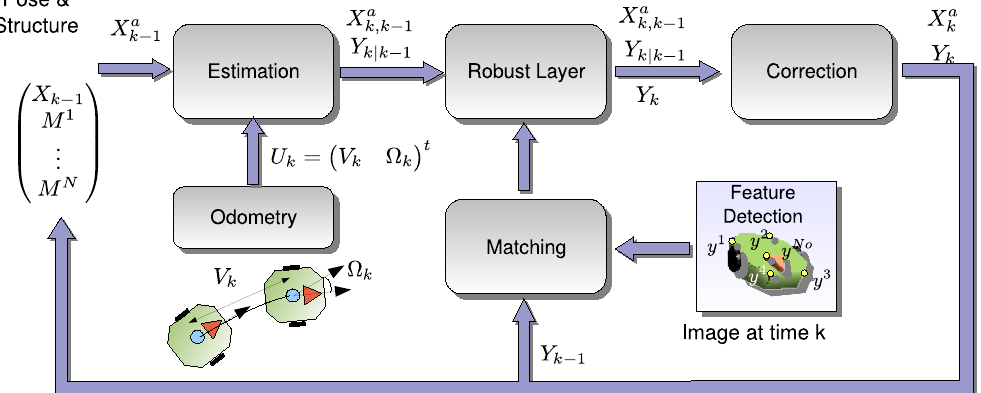
Figure 6. Overview of the online